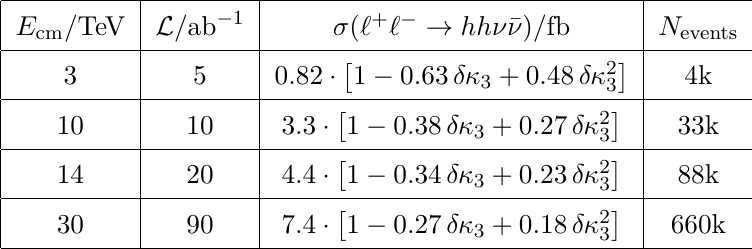
Table 6 . Total di-Higgs production cross-section from charged VBF, with its dependence on the trilinear coupling modification δκ 3 , and total number of events at different collider